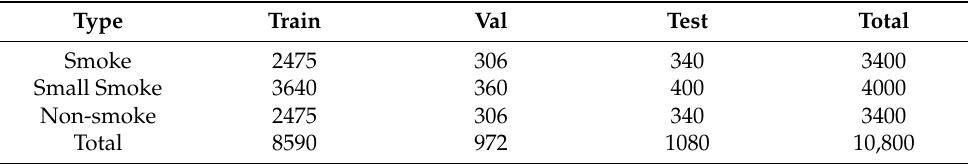
Table 1. Number of dataset categories.